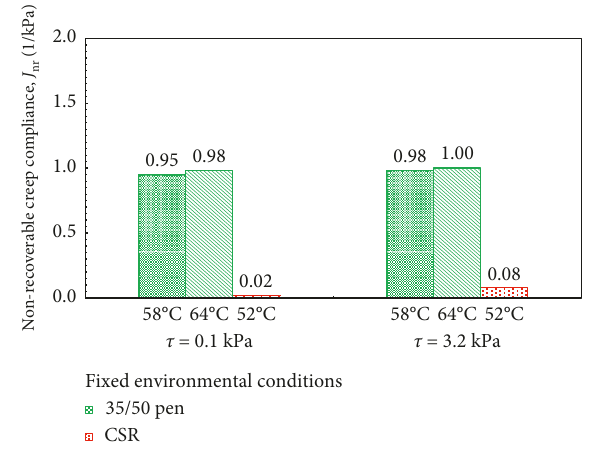
Figure 26: Hypothesis scenario ( J different